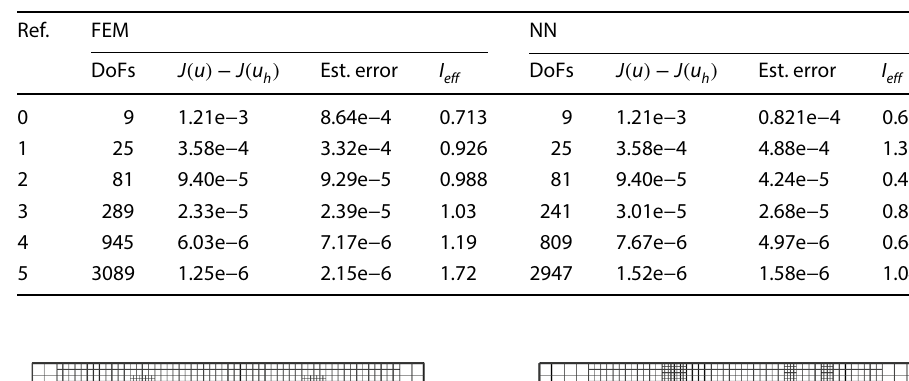
Fig. 6 Section 5.3: Grid refine- ment for the nonlinear